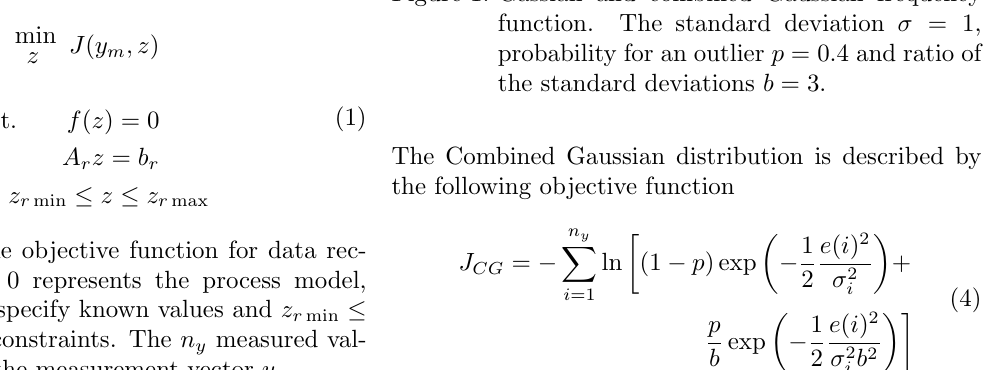
Figure 1: Gassian and combined Gaussian frequency